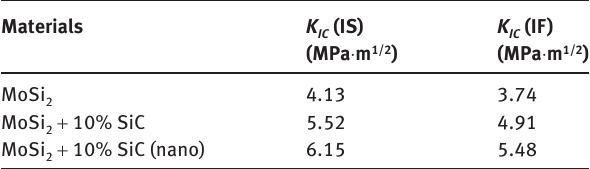
Table 1: Fracture toughness of the investigated materials